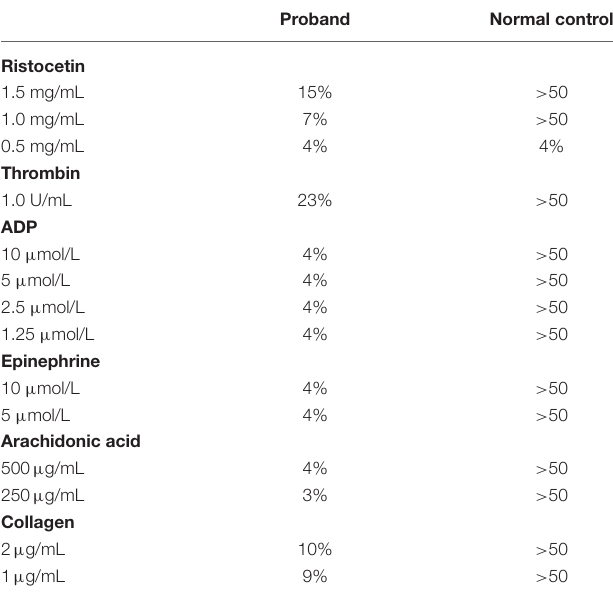
TABLE 1 | Results of his platelet aggregation studies.